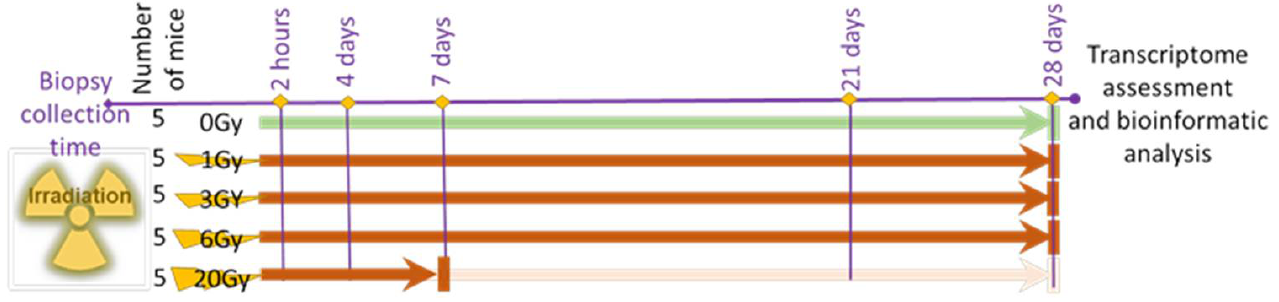
Figure 1. Study design. Five groups each consisting of five animals received 0, 1, 3, 6, or 20 Gy of whole-body X-ray irradiation. Animal skin biopsies were collected at 2 h and day 4, 7, 21, and on euthanasia day 28. Animals exposed to 20 Gy did not complete the study time course and were euthanized on day 7.